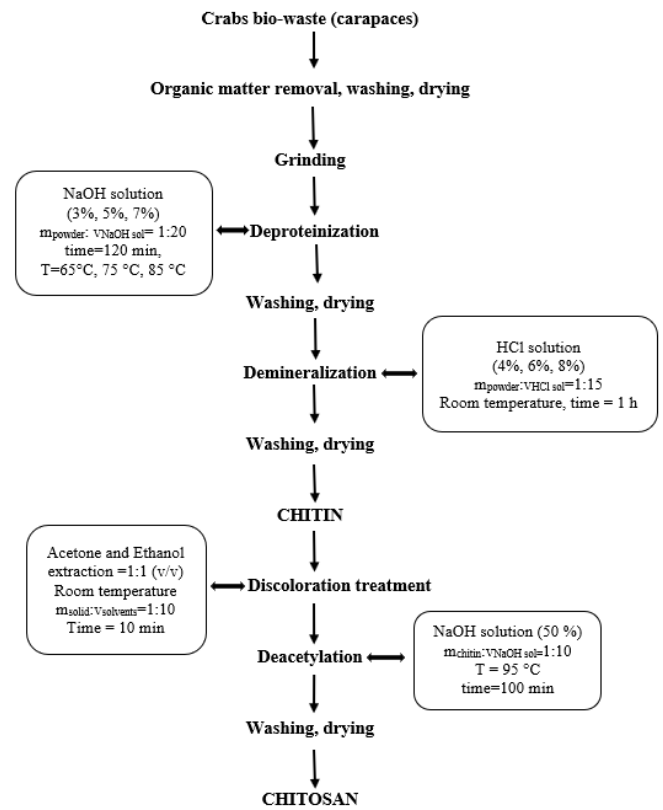
Figure 1. Chitosan extraction